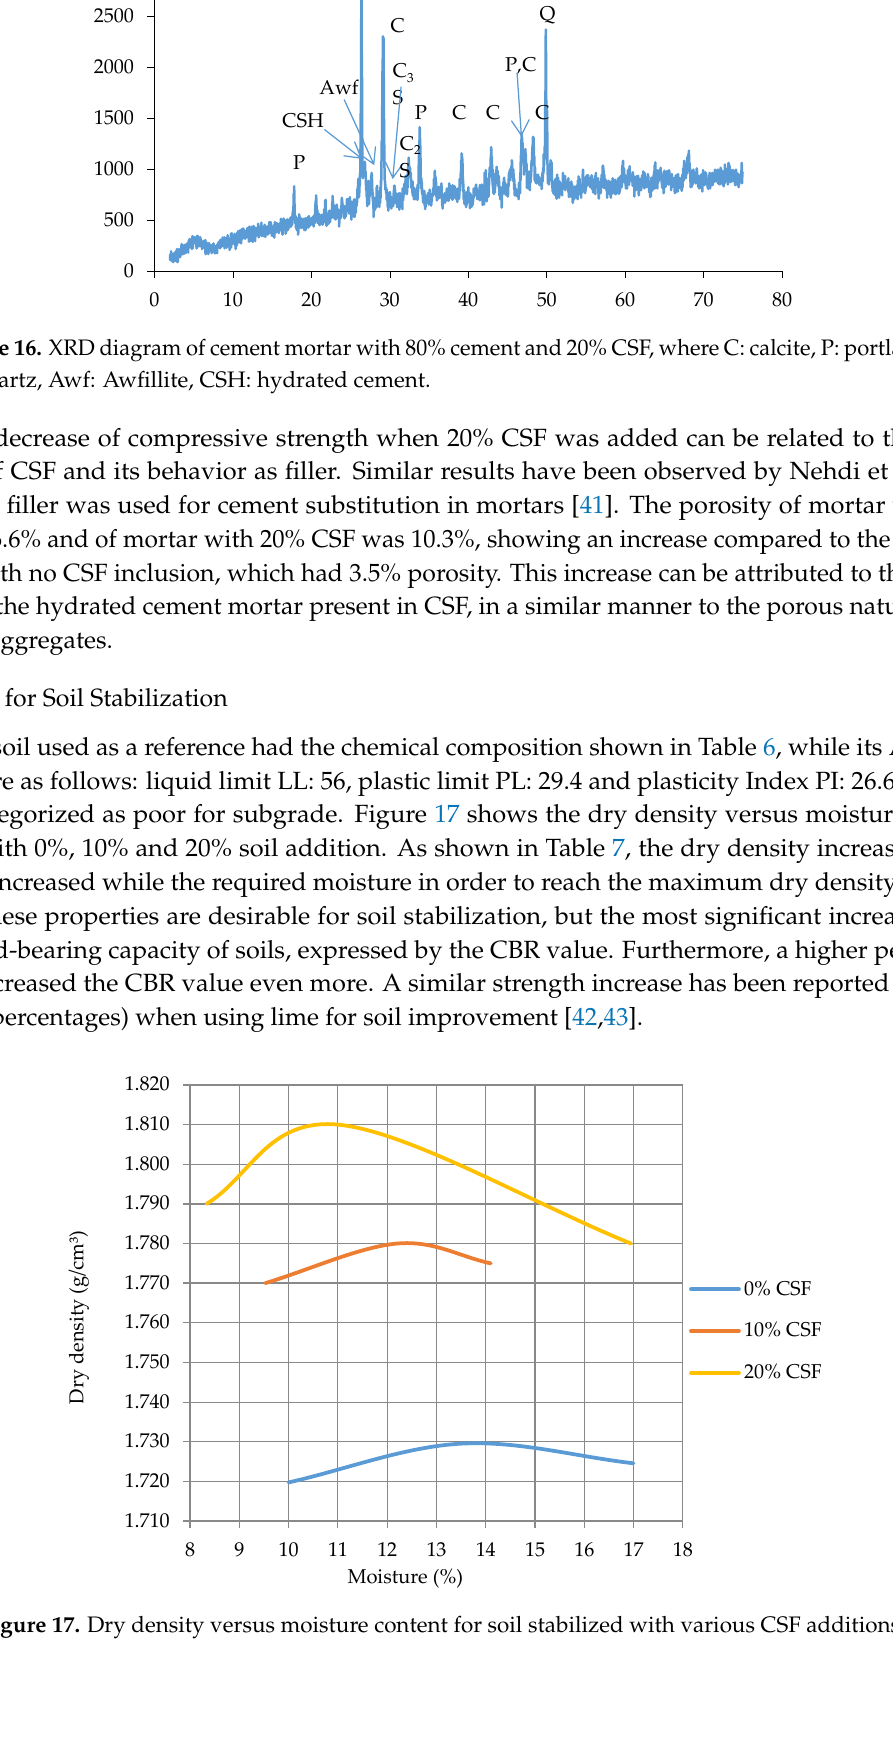
Figure 17. Dry density versus moisture content for soil stabilized with various CSF additions. Table 7. Soil stabilization test results.